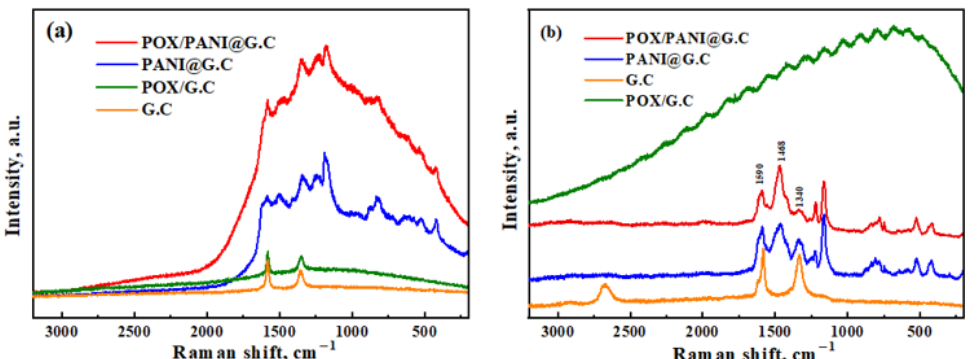
Figure 1. Raman spectra. The 514 nm ( a ) and 633 nm ( b ) excitation lines of G.C, POX @G.C, PANI @G.C, and POX/PANI@G.C.